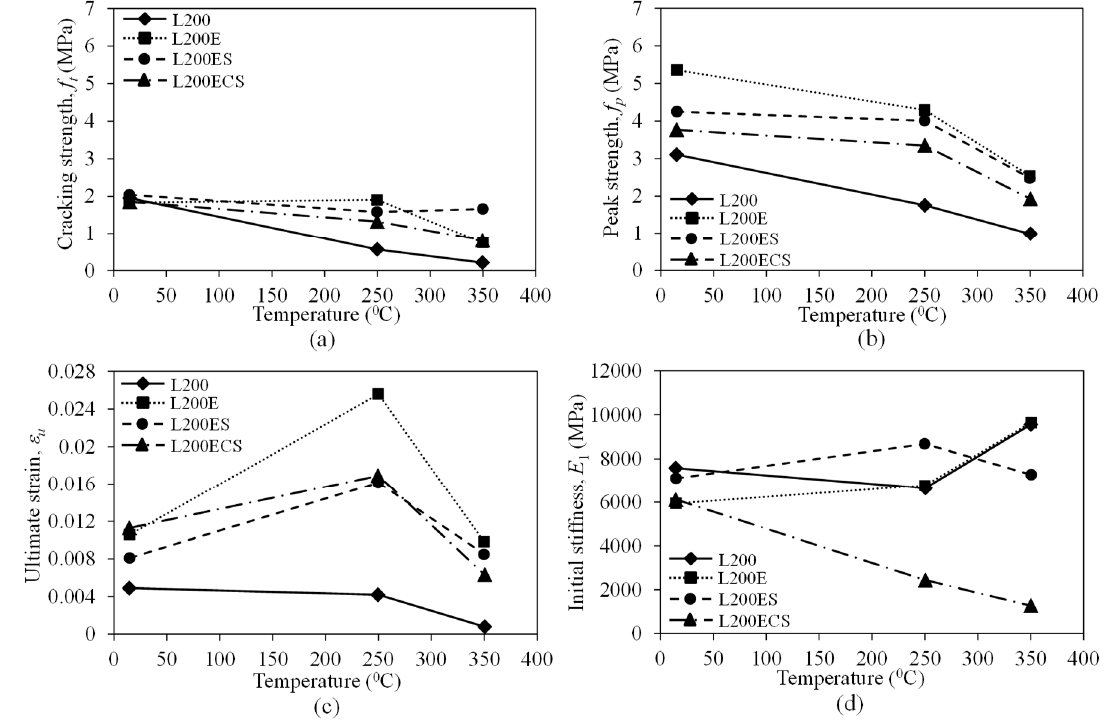
Figure 17. Evolution of ( a ) cracking strength, ( b ) peak strength, ( c ) ultimate strain, and ( d ) initial stiffness according to temperature of the TRM specimens in the third series.